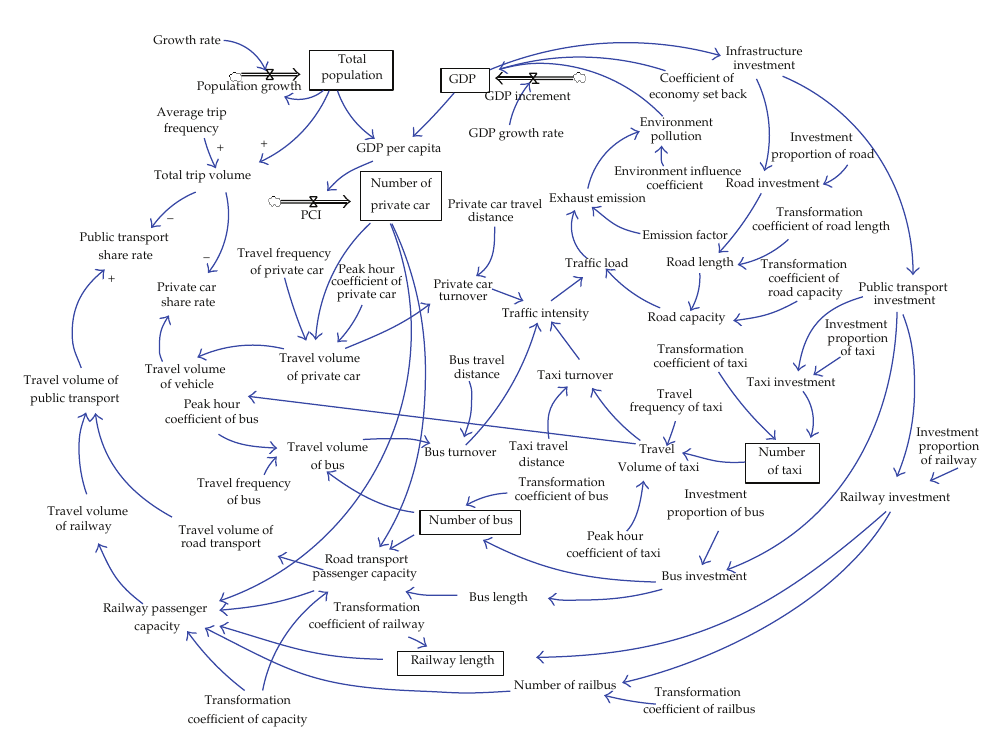
Figure 4: The stock and flow diagram of garden city transportation